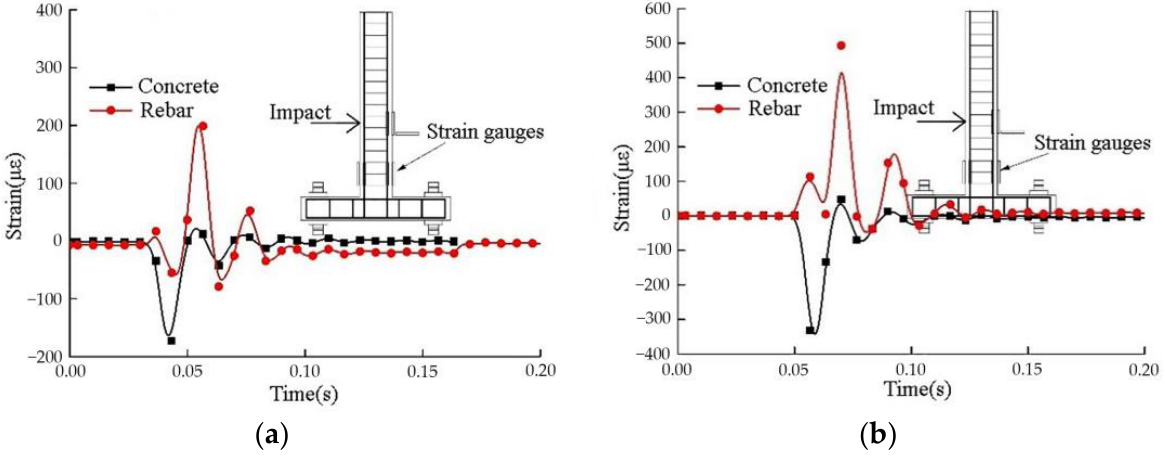
Figure 9. Inertial restraint effect during impact: ( a ) drop height = 30 cm and ( b ) drop height = 80 cm. The impact mass was modified by adding weight to the model car, with a single ballast weighing 2 kg. The strain time history of the concrete when the drop height was 1.5 m is shown in Figure 10. As can be seen from the picture, when the mass of the model car increased by 22.8% and 45.6%, the extreme concrete strain at the same position increased by 22.5% and 42.3%,